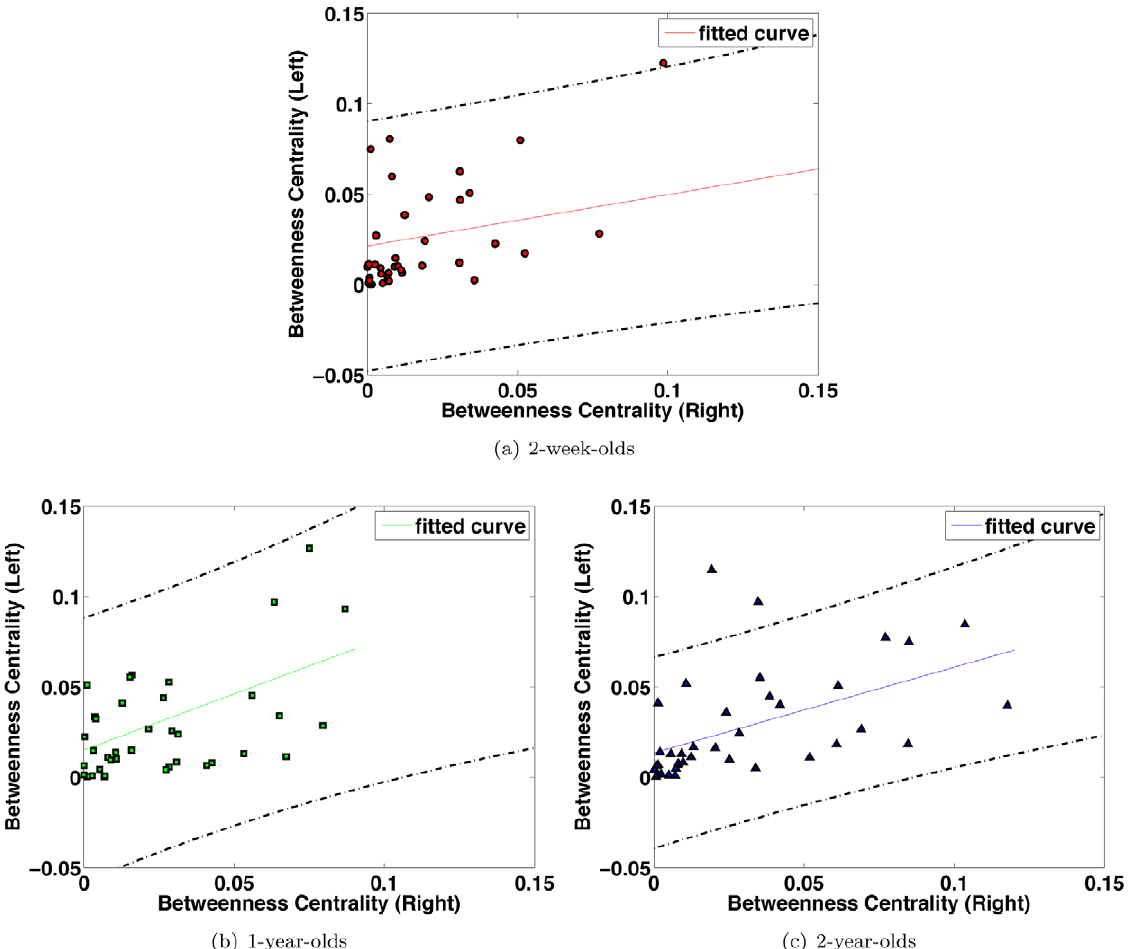
Figure 11. Inter-Hemispheric Correlation of Node Betweenness. Each circle gives the left and right betweenness value for each node. Each age group shows a rightward assymetry - indicated by the slope values 0.2843, 0.6202, and 0.4738, respectively (1 indicates perfect symmetry). The dashed lines indicate 95% confidence interval. The betweenness centrality value is normalized by division by (78 { 1)(78 { 2) = 2 ~ 3003 .